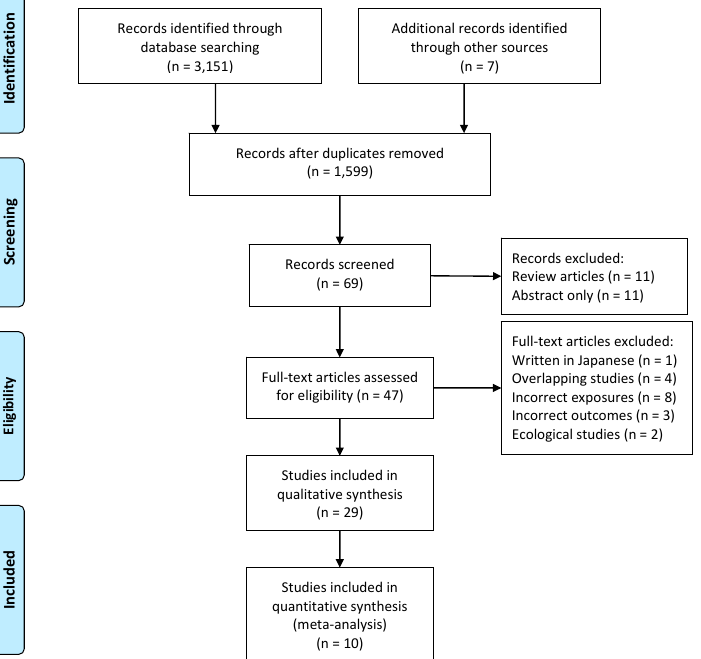
Figure 1. Flowchart of the literature screening by preferred reporting items for systematic reviews and meta-analyses (PRISMA).